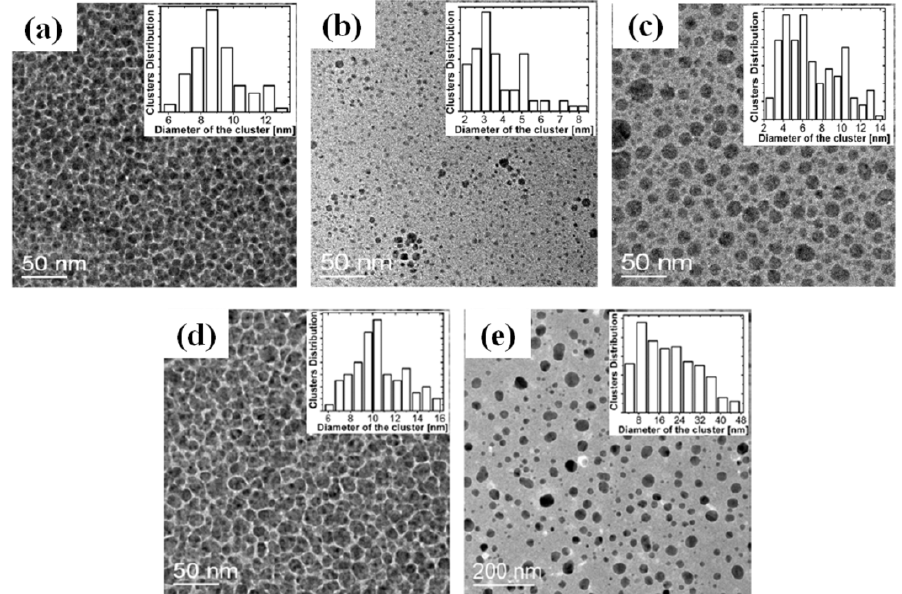
Figure 9. TEM images of of Nylon/Ag nanocomposites at various metal filling factors: ( a ) 4.4%, ( b ) 14%, ( c ) 21% and ( d ) 40.5%. (Reproduced with permission from [51], Copyright IOP Publishing